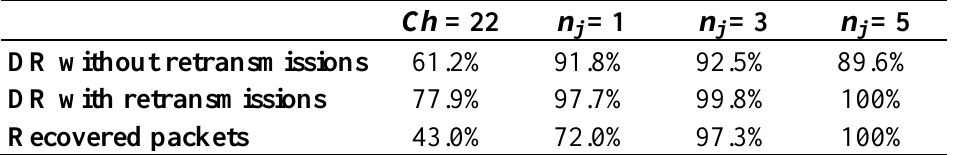
Table 4. Experimental results concerning the use of the frequency hopping